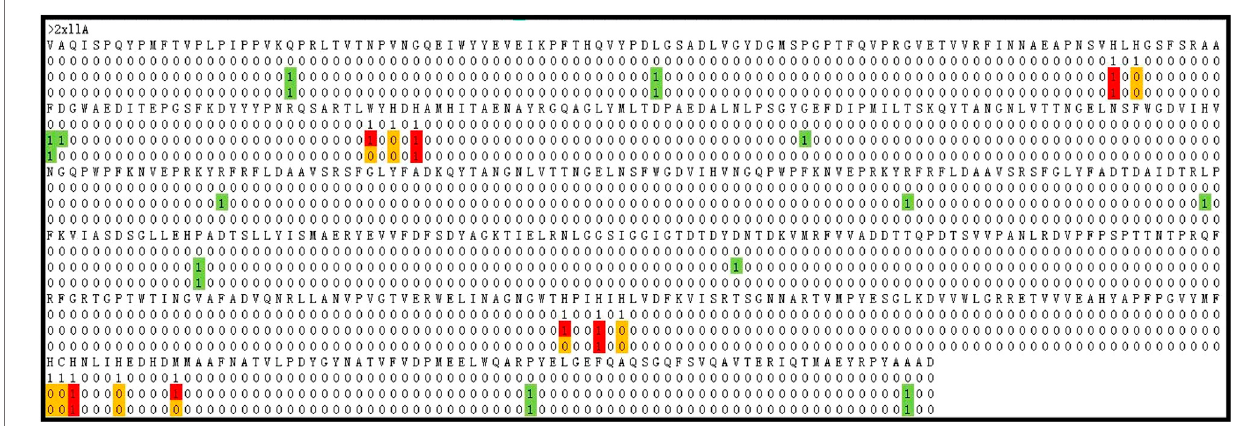
FIGURE 8 | The comparison of identi fi cation results. Note: The fi rst row is the protein sequence, the second row is the experimental results, the third row is the optimal predicted results, and the fourth row is the predicted results using the basic parameters. “ 0 ” is the non-binding residue, “ 1 ” is the binding residue. The red ones indicate TP. The white ones indicate TN. The yellow ones indicate FN. The green ones indicate